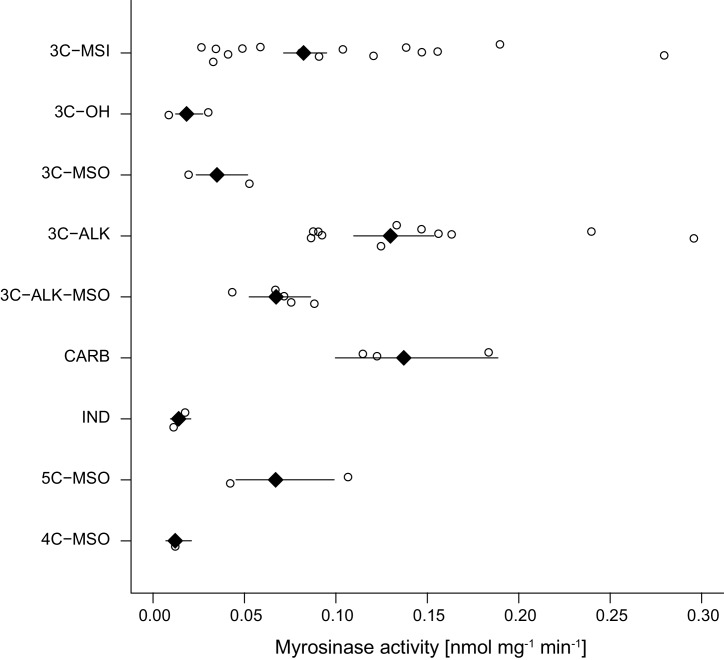
Myrosinase activity of leaf extracts from 43 Erysimum species, grouped by glucosinolate chemotype.Open circles are species means and black diamonds are chemotype means ± 1 SE. See also Figure 7 for chemotype information. 3C/4C/5C = length of carbon side chain, MSI = methylsulfinyl glucosinolate, MSO = methylsulfonyl glucosinolate, OH = side chain with hydroxy group, ALK = side chain with alkenyl group, CARB = carboxylic glucosinolate, IND = indole glucosinolate.Figure 8—source data 1.Species means for myrosinase activity and glucosinolate chemotype classification.